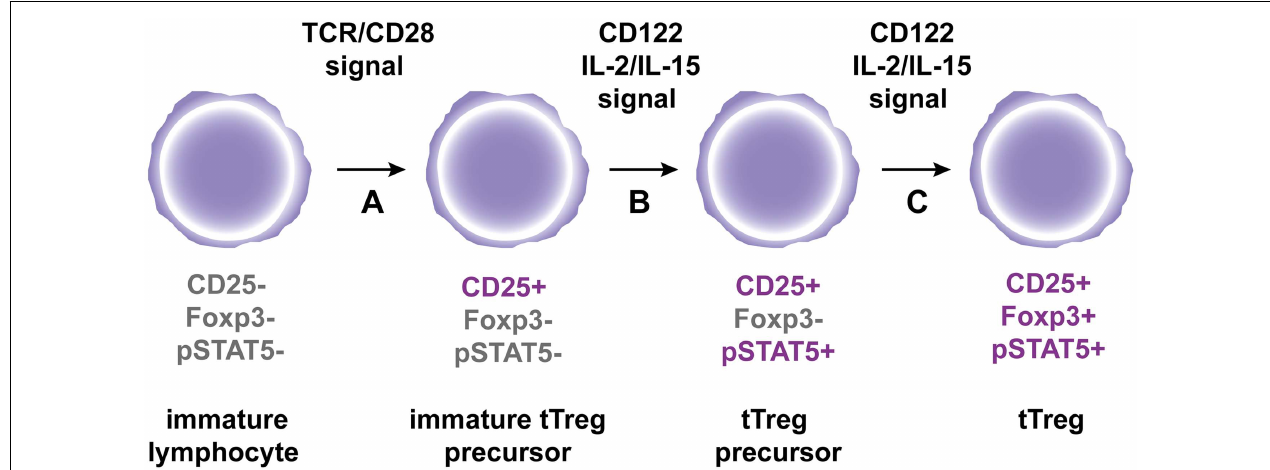
CD122 signaling cytokines IL-2 and IL-15 leads to STAT5 phosphorylation to generate tTreg precursors. (C) Following continuous engagement of CD122, Foxp3 expression is induced in tTreg precursors to generate fully mature